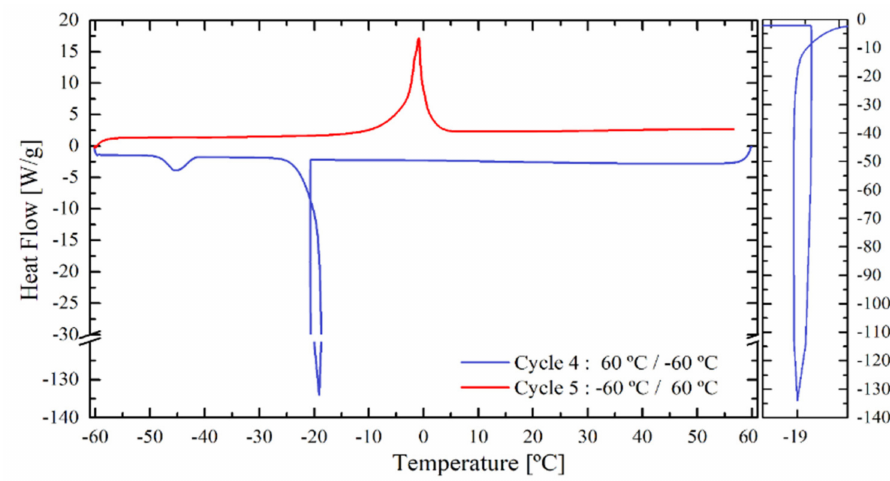
Figure 12. Freezing and heating DSC thermogram of the ITA latex with 10 wt % water.